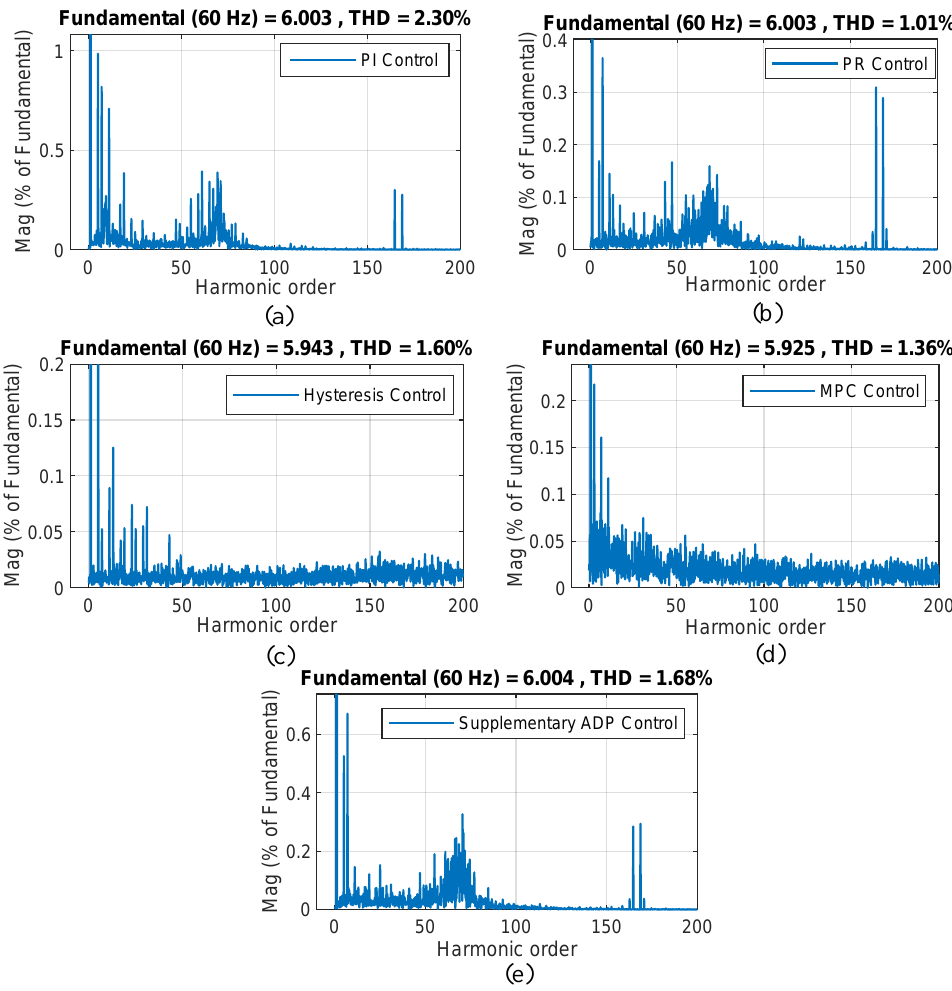
Figure 14. Comparison of the harmonic spectrum of the output current. ( a ) PI controller. ( b ) PR controller. ( c ) Hysteresis controller. ( d ) MPC. ( e ) Supplementary ADP controller. THD: Total Harmonic